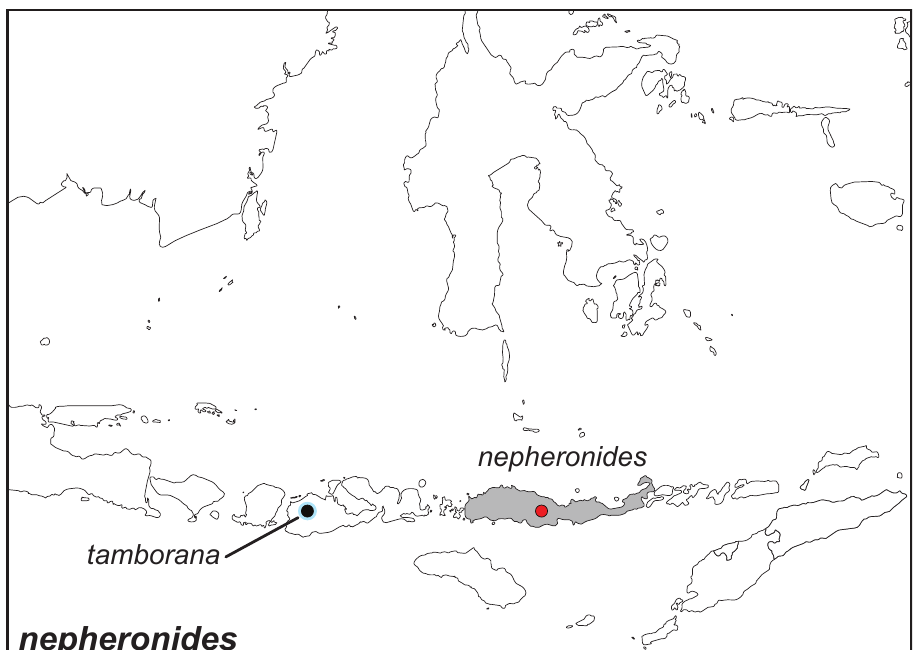
Figure 44. Distribution map of Elymnias nepheronides